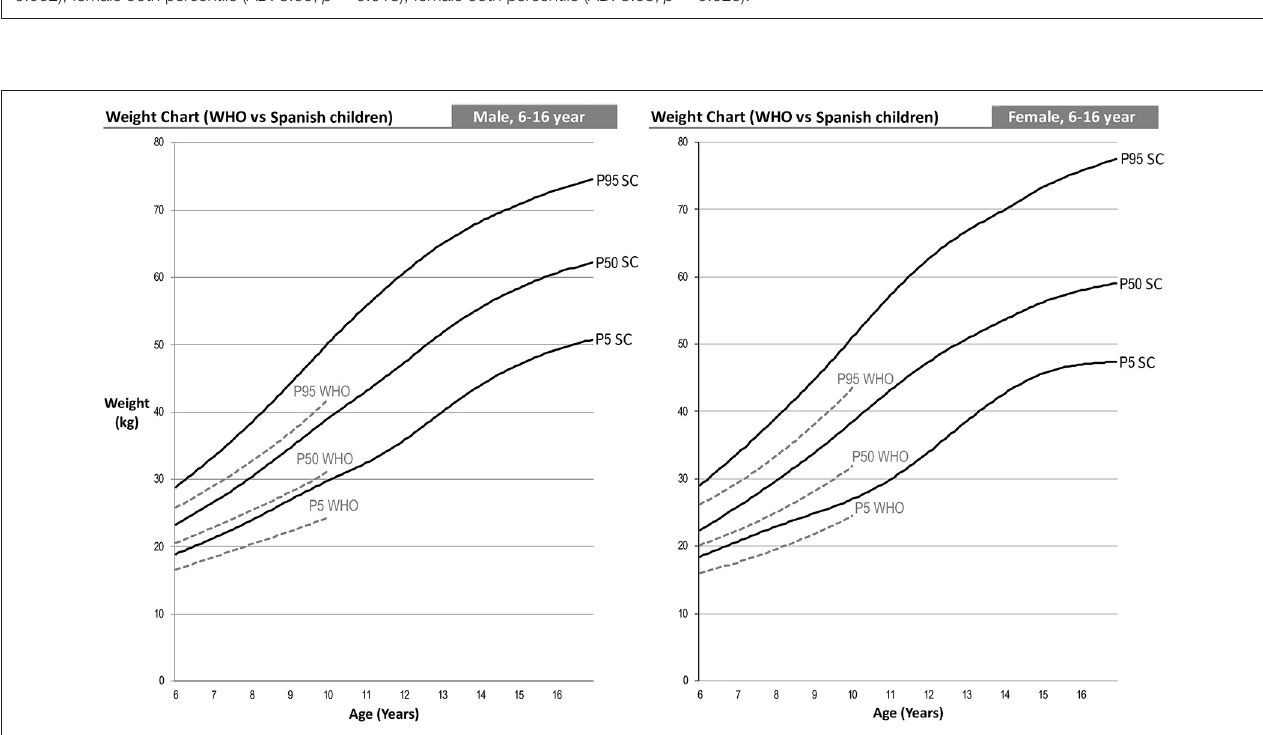
FIGURE 4 | Comparison of the 2007 WHO height percentile and children from eastern Spain. Two-sample Anderson Darling test for goodness of fit of the curves: male 5th percentile (AD: 3.84; p = 0.010); Male 50th percentile (AD: 3.03; p = 0.026); male 95th percentile (AD: 3.24; p = 0.020); female 5th percentile (AD: 5.39; p = 0.002); female 50th percentile (AD: 3.60; p = 0.013); female 95th percentile (AD: 3.08; p = 0.025).